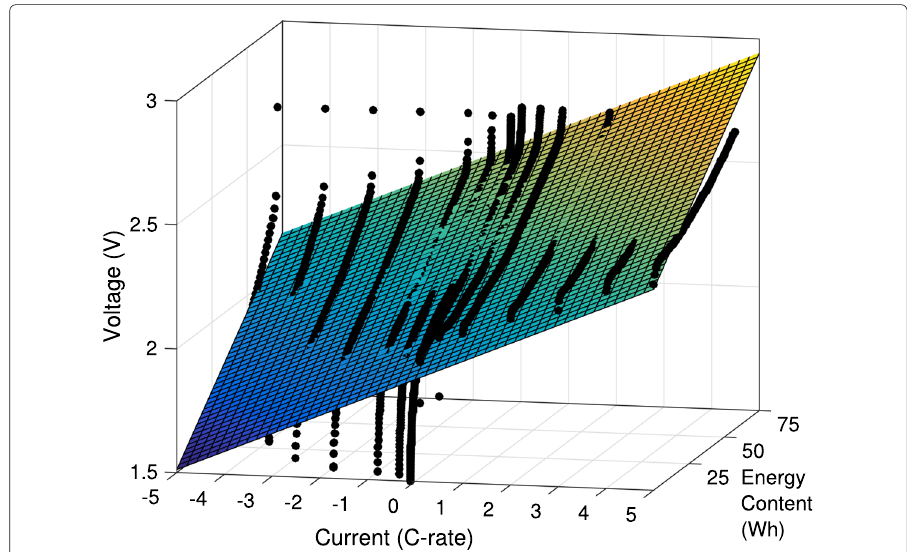
Fig. 2 M function, represented by the black dots which map the applied current and energy content to a unique voltage and are obtained from a spec sheet. The plane is a linear approximation to the M function (Eq.